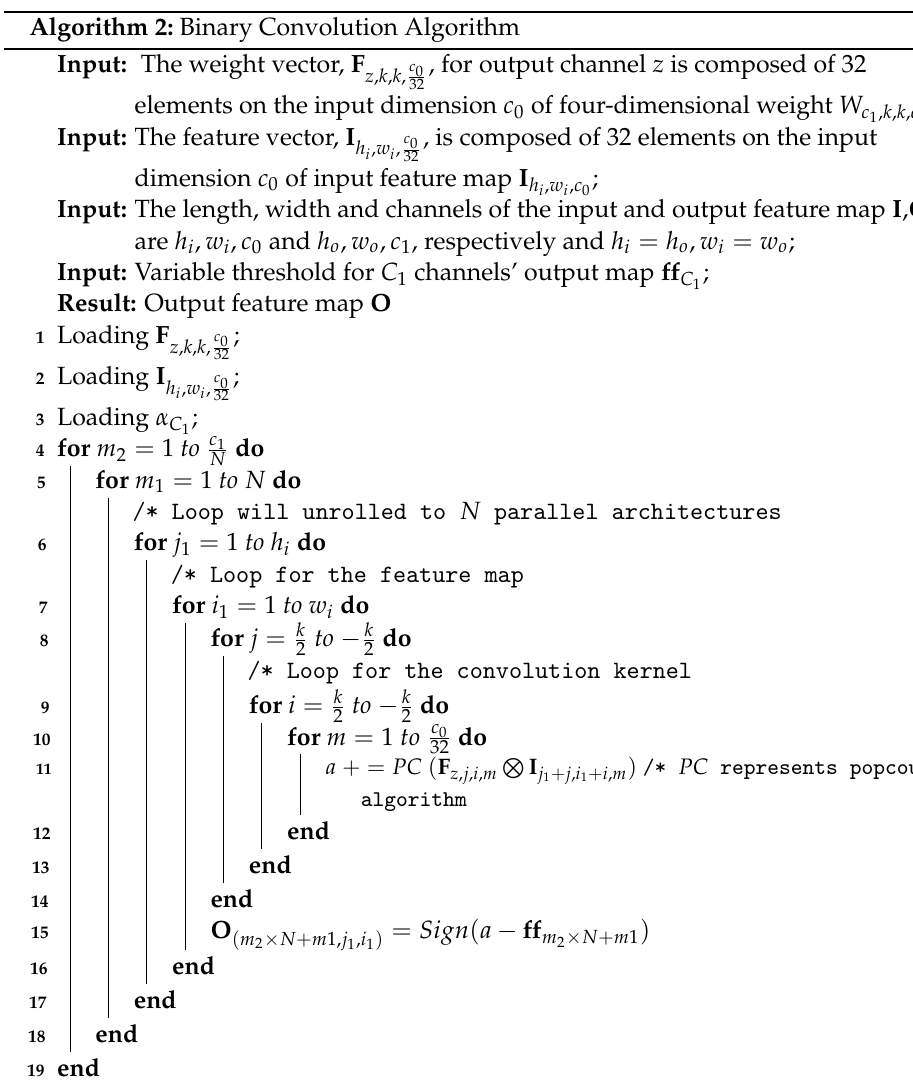
Algorithm 2: Binary Convolution